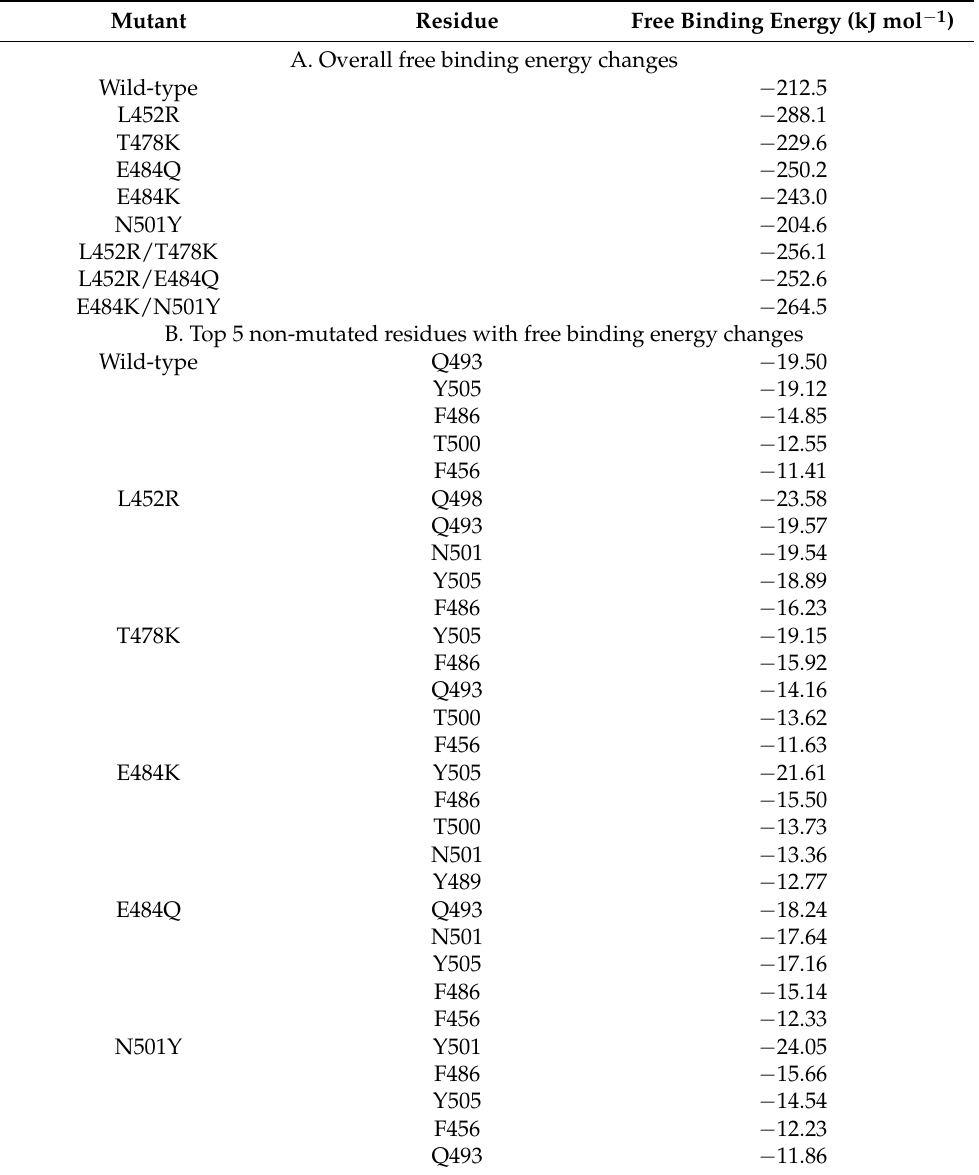
Table 1. Free binding energy changes between mutated RBD and